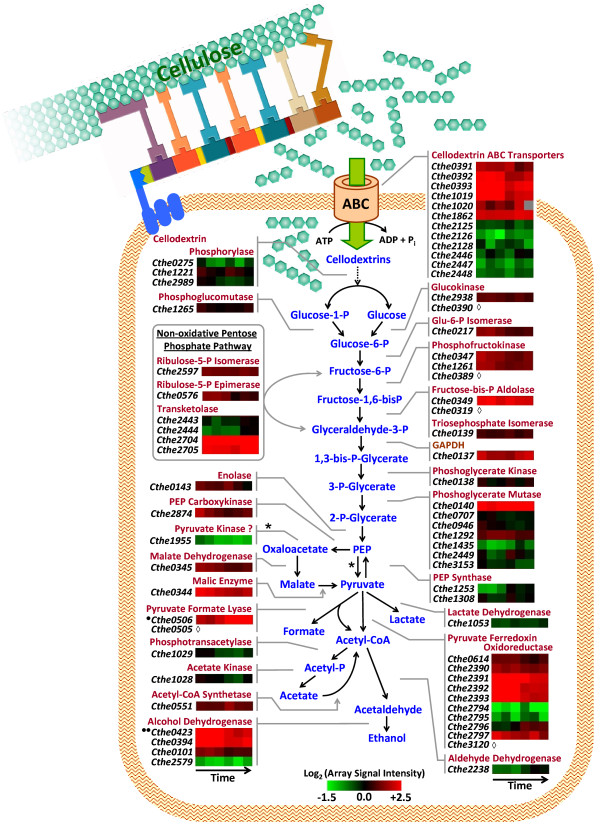
Expression of genes involved in cellodextrin transport and catabolism during cellulose fermentation. Schematic representation of cellulose degradation by cell surface attached cellulosomal complex, transport of cellodextrin hydrolysis products into the cell by ABC sugar transporters and intracellular catabolism of glucose to various metabolic end-products. Heat plot representation of transcript expression [as Log2 (array signal intensity)] for genes (known and putative) involved in cellodextrin transport and hydrolysis, pentose phosphate pathway, glycolytic conversion of glucose to pyruvate and anaerobic fermentation of pyruvate to organic acids (formate, lactate, acetate) and ethanol, over the course of Avicel® fermentation by Clostridium thermocellum ATCC 27405. Cellulosome schematic is an adaptation of the image from the U.S. Department of Energy Genome Programs website image gallery (http://genomics.energy.gov; [40]);one black circle - Cthe0506 is pfl-activating enzyme; two black circles - Cthe0423 encodes a bi-functional acetaldehyde/alcohol dehydrogenase enzyme involved in direct conversion of acetyl-CoA to ethanol; open diamond - Microarray data is not available.